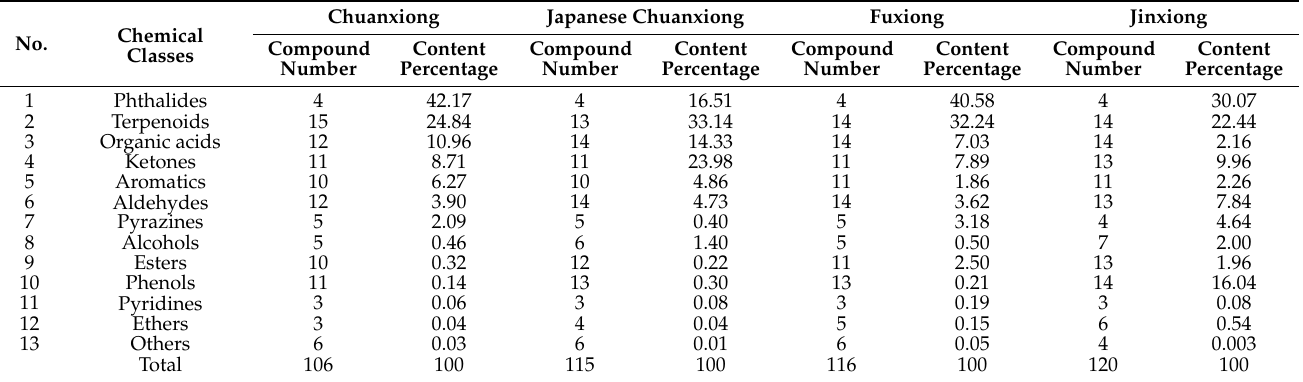
Table 4. The quantity and ratio of volatile compounds detected in specific chemical classes in the four